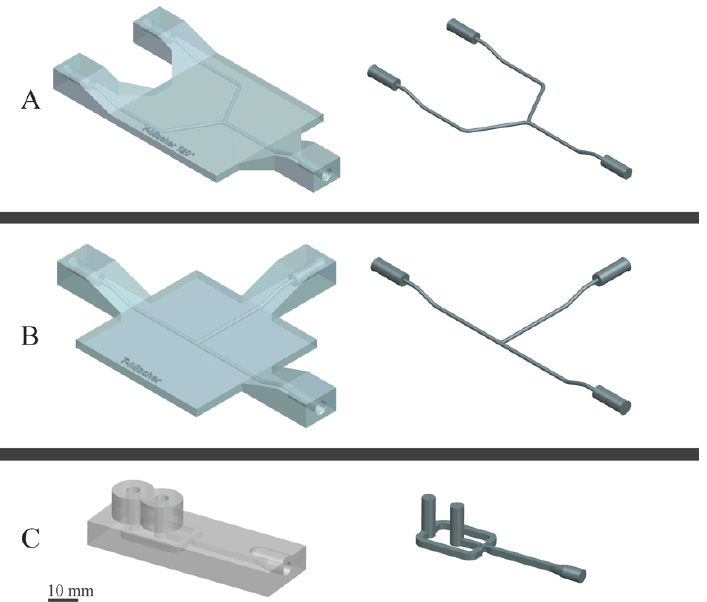
Figure 2. Schematic representation of the mixers used for the continuous nanoprecipitation and the orientation of their channels. ( A ) Y-mixer, ( B ) T-mixer and ( C ) focus-geometry micromixer. The printed objects were used without further treatment. For connecting the mixers to the pumps, M6 screw threads were cut using a thread cutter.